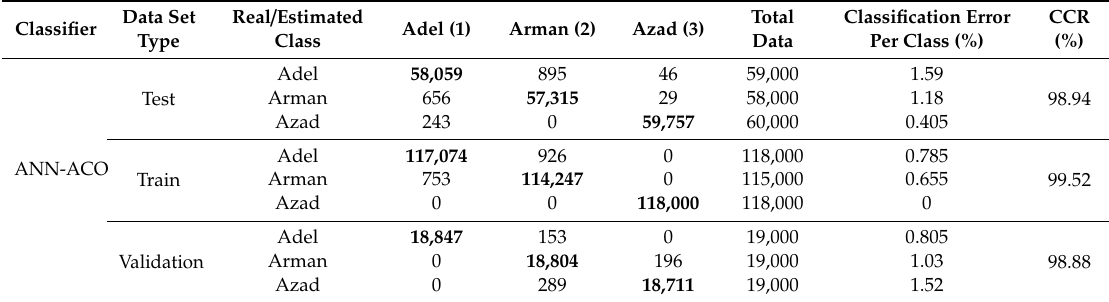
Table 6. Confusion matrix including correct classification rate (CCR) for ANN-ACO classifier: Adel, Arman and Azad chickpea ( Cicer arietinum L.) varieties (1000 uniform random iterations, test train and validation sets).